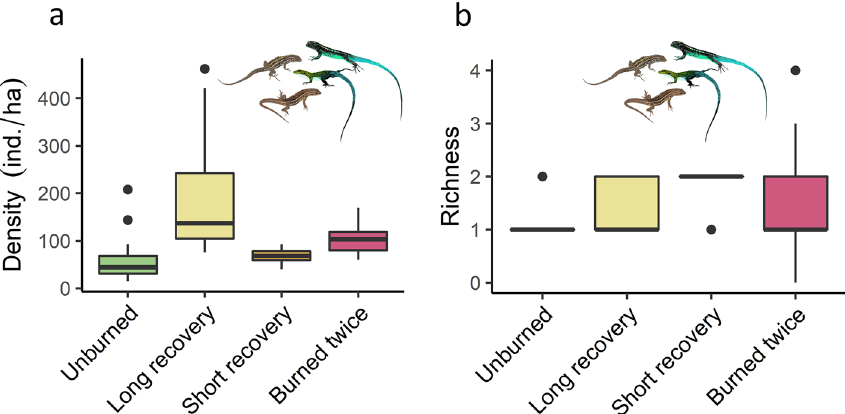
Figure 2. Total density ( a ) and richness ( b ) in each treatment for the lizard community in Araucaria forests from the Araucarias Biosphere Reserve (ABR) in the Andes of La Araucanía Region, Chile. Density estimates are based on predictions from best HDS models for each species. For richness results we used data from the 7 species